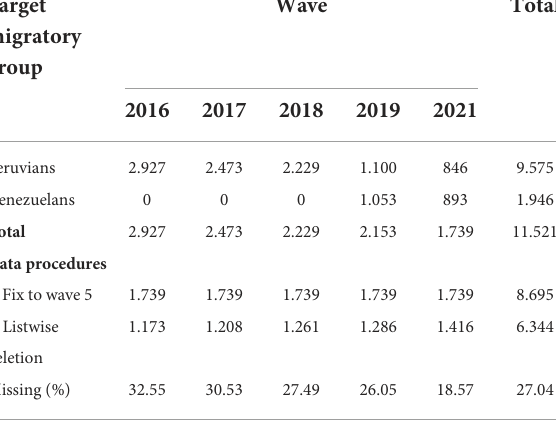
TABLE 1 Summary of the original